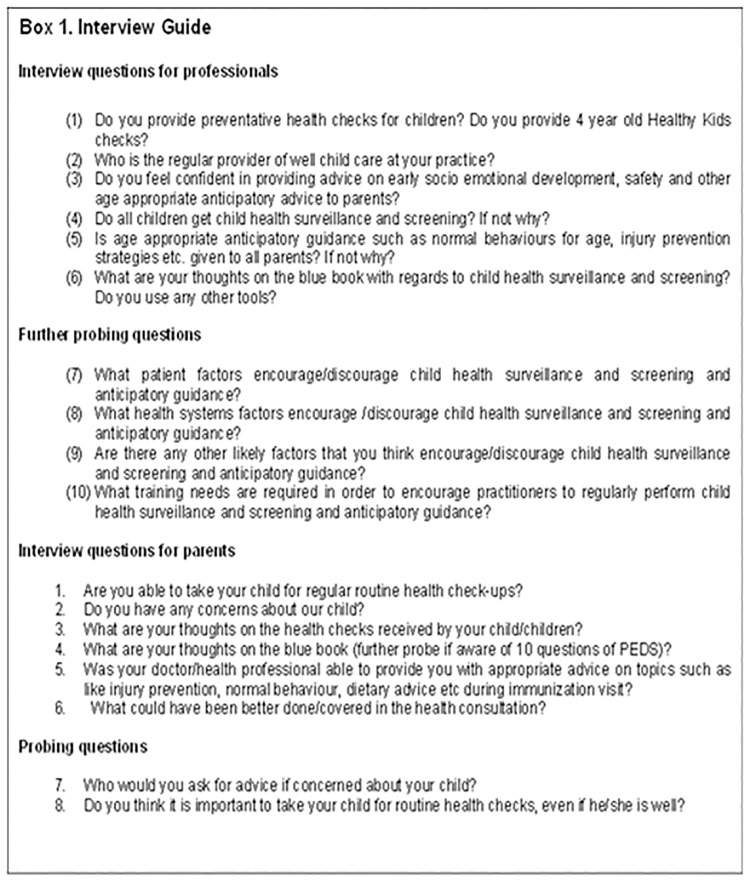
Interview guide.